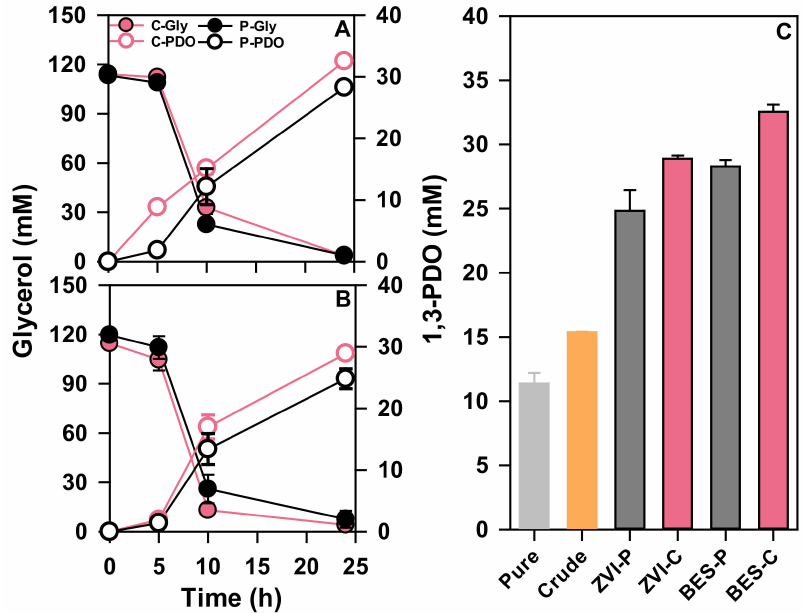
Figure 5. Crude and pure glycerol (100 mM) applied to BES and ZVI. Productivity of 1,3-PDO and glycerol consumption using ( A ) BES, ( B ) ZVI, and ( C ) 1,3-PDO production with and without ZVI and BES for crude and pure glycerol (P: pure glycerol; C: crude glycerol).